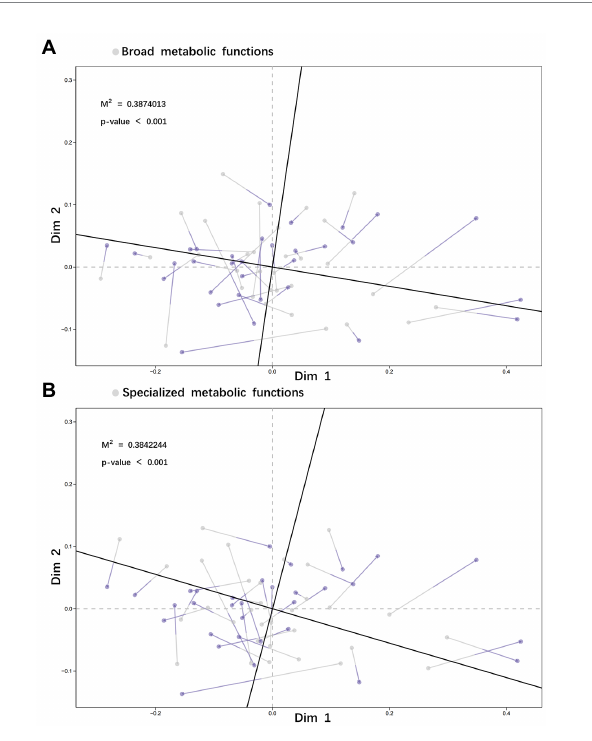
FIGURE 5 Species within functional groups based on the NMDS (Bray–Curtis) were correlated with broad metabolic functions (A) and specialized metabolic functions (B) in a procrustes analysis (Permutations = 999). The 20 species with the highest relative abundance in the functional groups (more than 95% of the total species abundance) were selected, and their metabolic functional gene abundance was also the highest both in broad and specialized